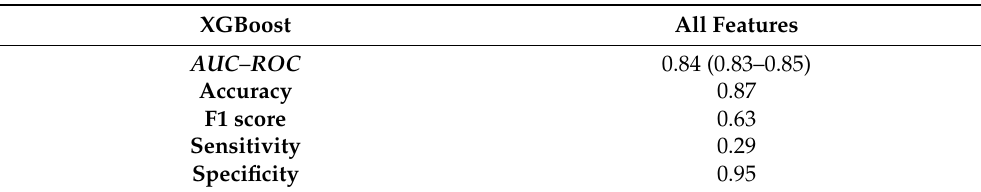
Figure 9. ROC curve for early mortality in ICU patients with VTE from eICU dataset (XGBoost). Table 6. Detailed metrics of performance for prediction of early mortality of ICU patients with thrombosis using all